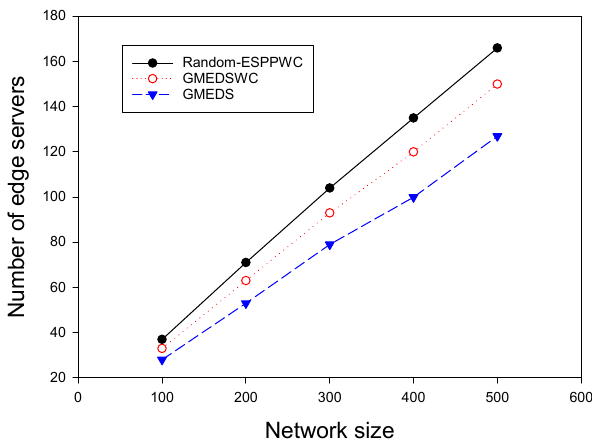
Figure 6. The impact of network size with identical